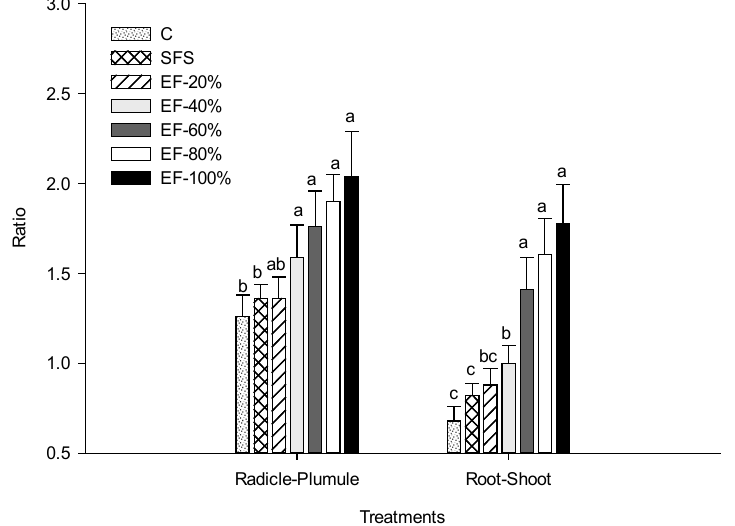
Figure 13. Radicle-plumule as well as root-shoot ratio of tomato seedlings.